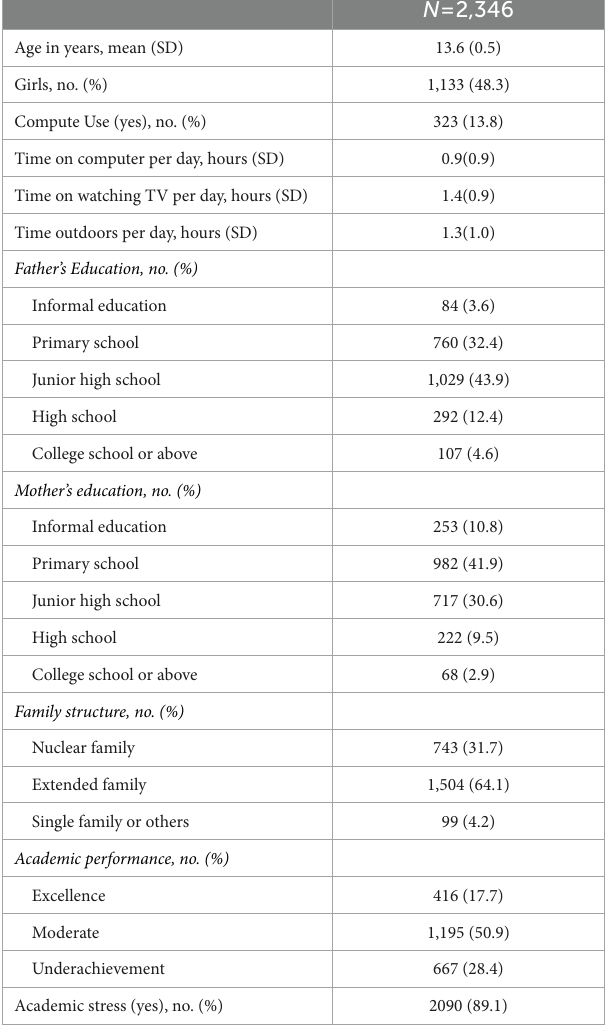
below, with only 17.0% (399) of their fathers and 12.4% (270) of their mothers who graduated from college or had a higher degree. TABLE 1 Distributions of children by their